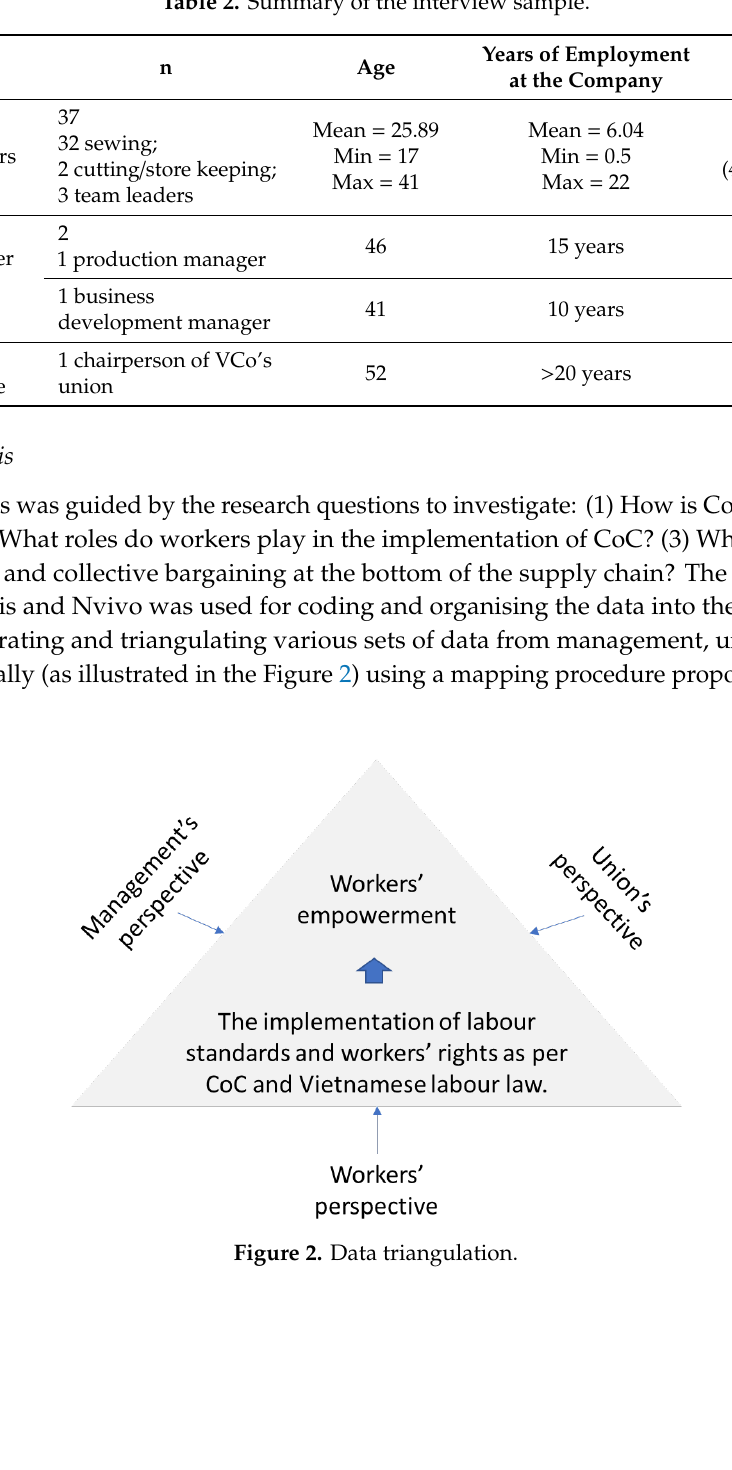
Table 2. Summary of the interview sample.